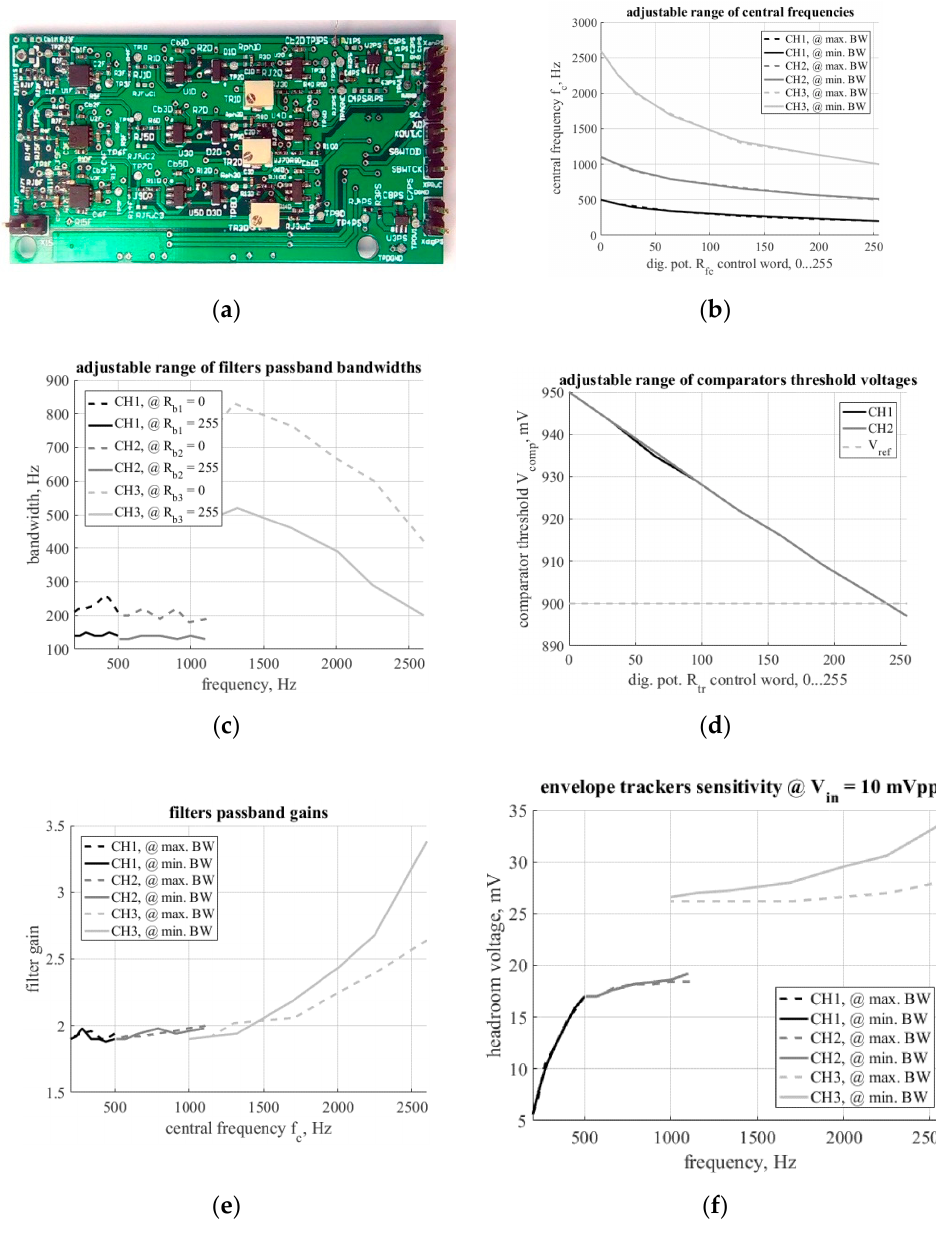
Figure 2. Design characterization. ( a ) PCB; ( b ) Range of filters central frequencies (adjusted by R fc ), ( c ) bandwidths (set by R b ), and ( d ) span of comparators thresholds ( R tr ); ( e ) Filters’ gains ( V filt /V in ); ( f ) Envelope trackers’ sensitivities ( V env